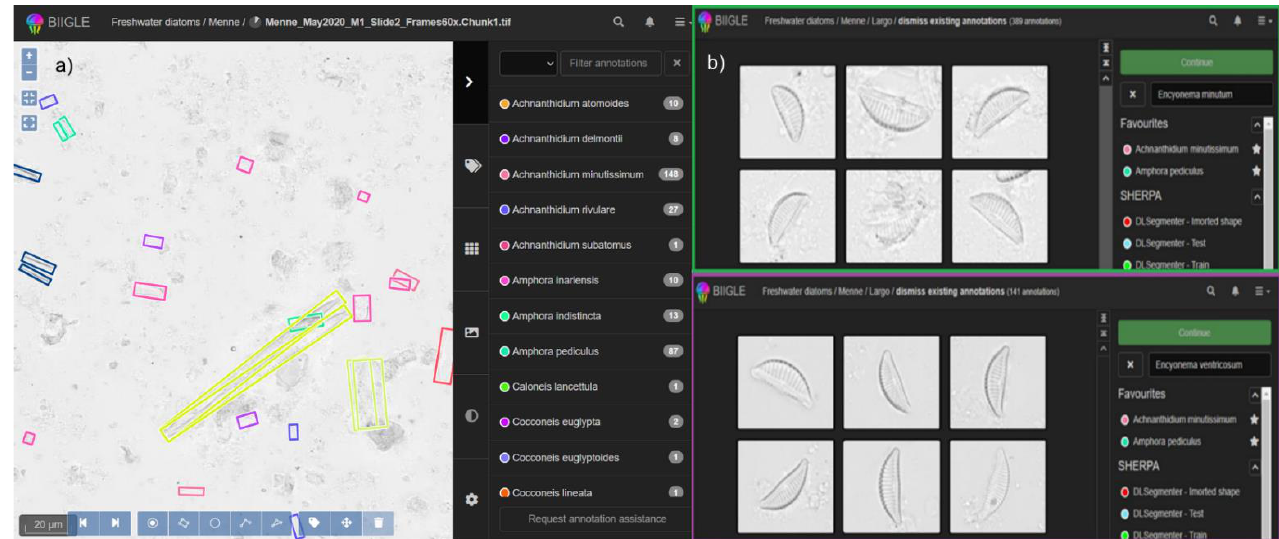
Figure 3. Examples of BIIGLE functions: ( a ) completely identified sample with identification labels, each frustule/valve and label can be revisited if necessary e.g., for quality control. ( b ) LARGO function comparing morphologically similar species of the Encyonema genus for possible taxonomical updates.